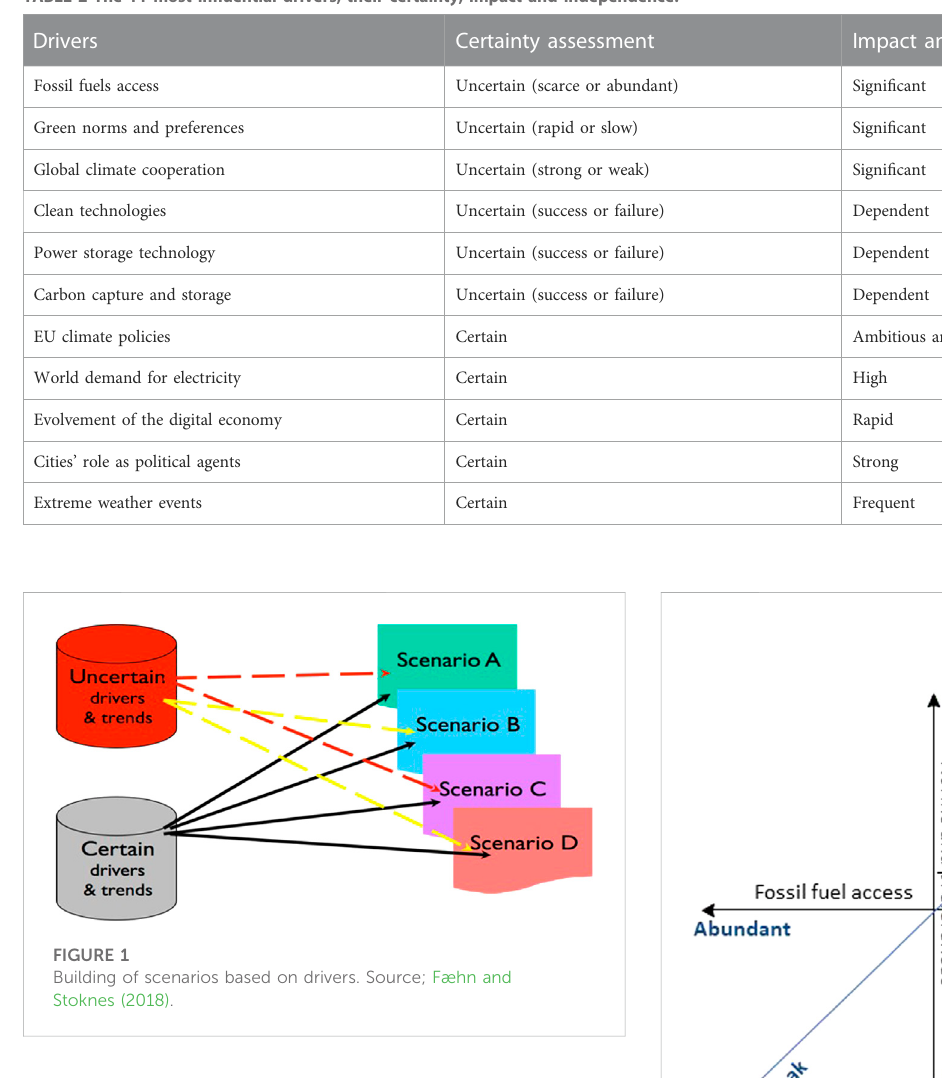
TABLE 2 The 11 most in fl uential drivers, their certainty, impact and independence.